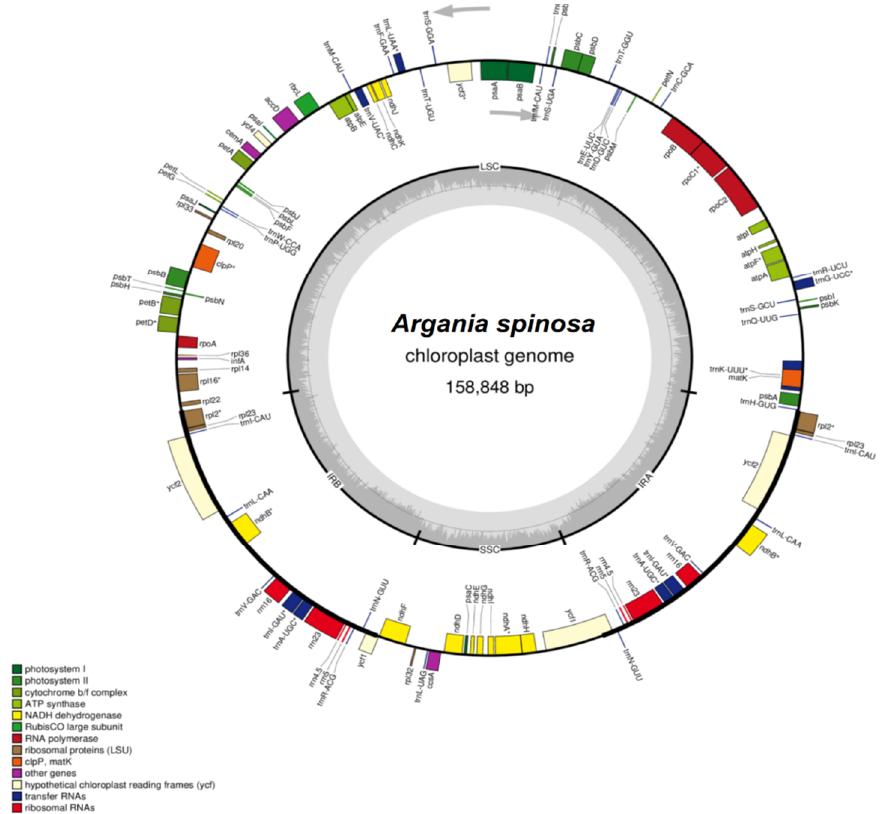
Figure 1. Gene map of Argania spinosa chloroplast genome. The thick lines colored in black in the inner circle indicate the extent of the inverted repeat regions (IRa and IRb; 25,946 bp), which separate the genome into small (SSC; 18,593 bp) and large (LSC; 88,367 bp) single-copy regions. Genes drawn inside the circle are transcribed clockwise, and those on the outer side are transcribed counter-clockwise. Genes belonging to different functional groups are color-coded. The dark grey in the inner circle corresponds to the GC content, and the light grey corresponds to the AT content.